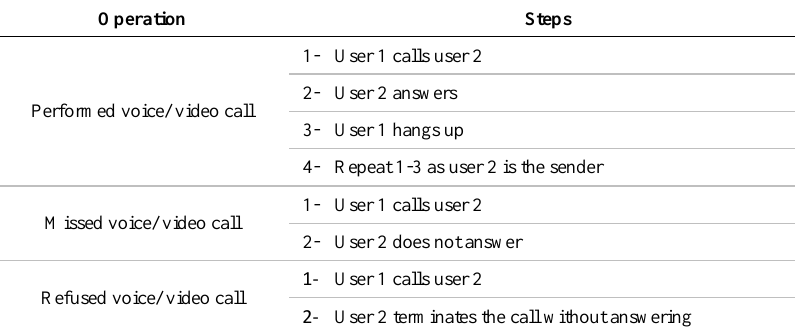
Table 5. WhatsApp voice and video calls